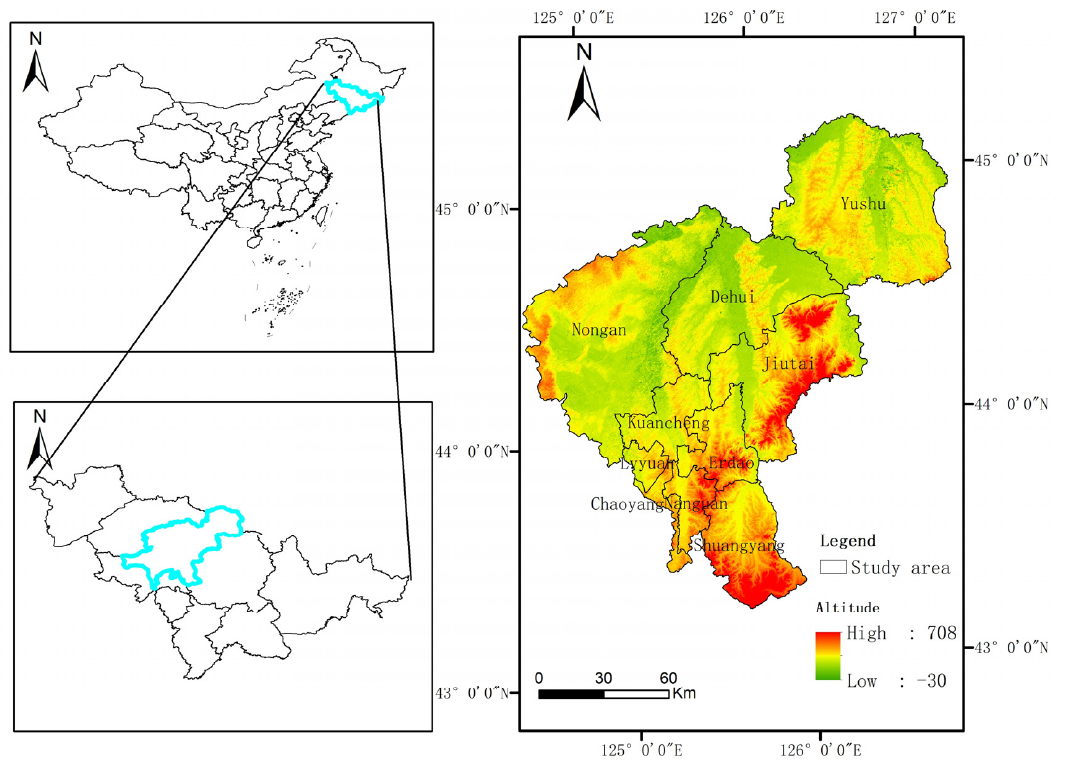
Figure 1. Location map of the study area.